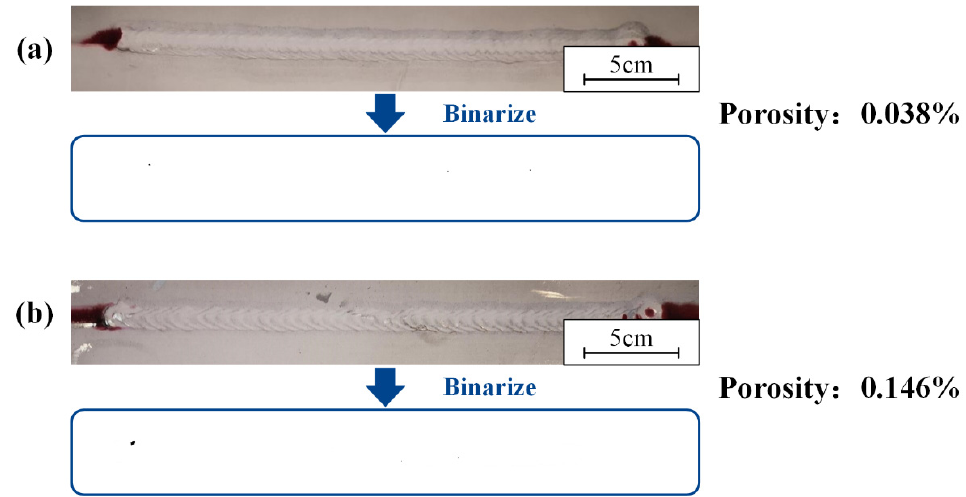
Figure 13. The result of the permeation testing and the porosity under different scanning frequencies: ( a ) 100 Hz; ( b ) 125 Hz.